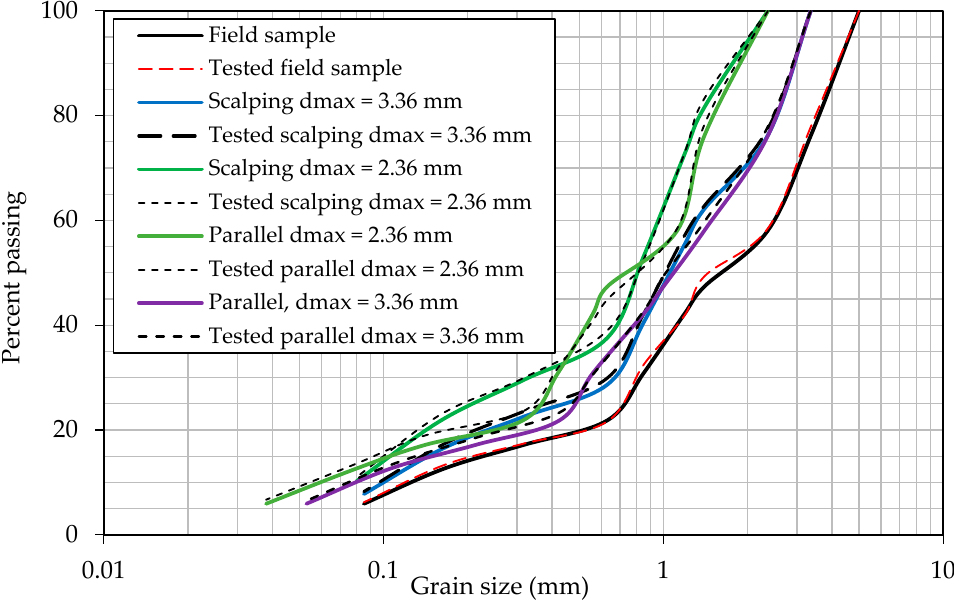
Figure 7. PSDCs of scaled down and field samples of M2 before (solid lines) and after (dashed lines) direct shear tests.